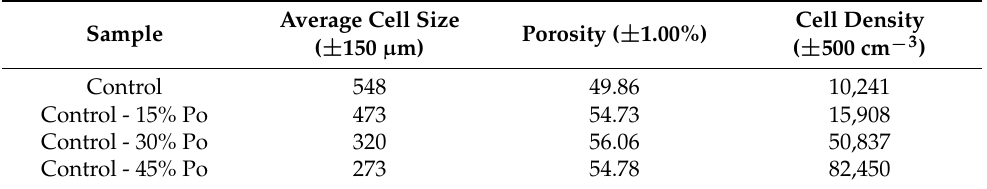
Table 2. Morphological characteristics of various foam samples: cell size and porosity were deter- mined by analysing the SEM images with ImageJ. The cell density was calculated using the same method in previous work